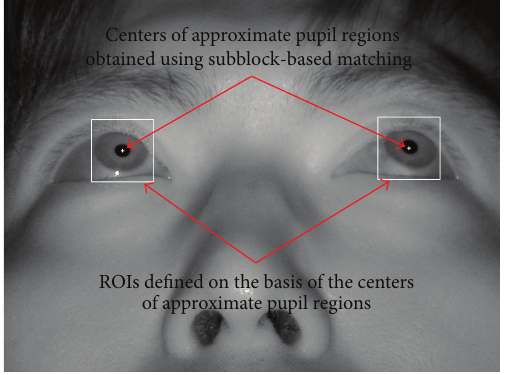
Figure 6: Result of the sample pupil region detection.